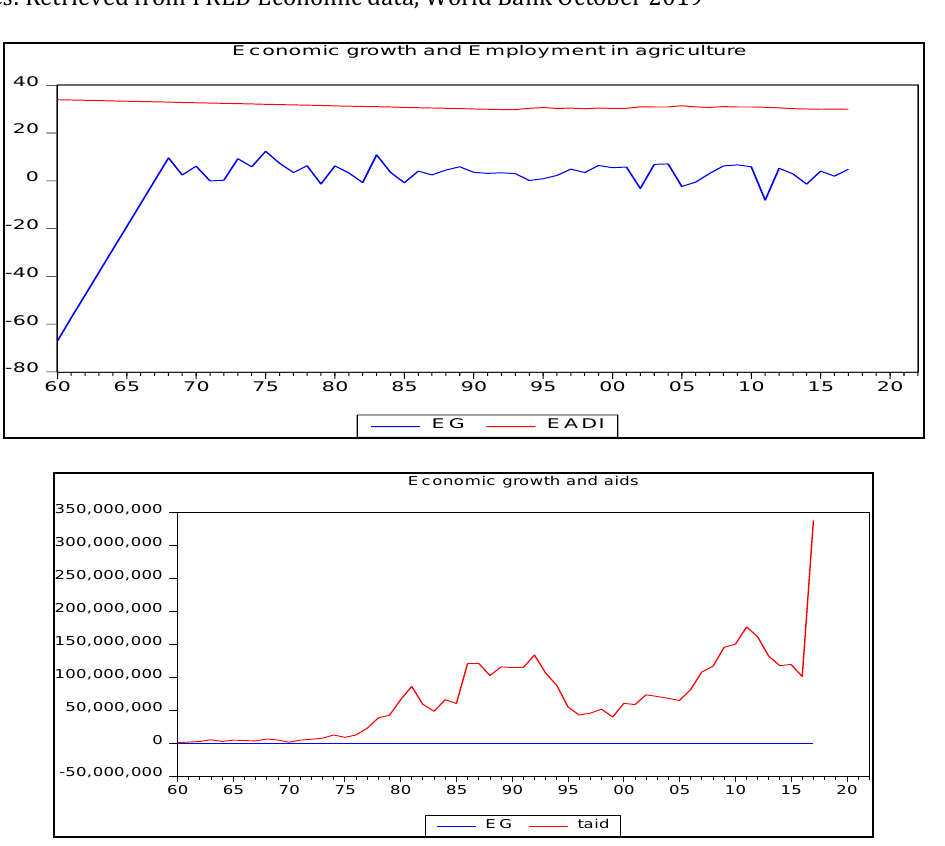
Sources : Retrieved from FRED Economic data, World Bank October